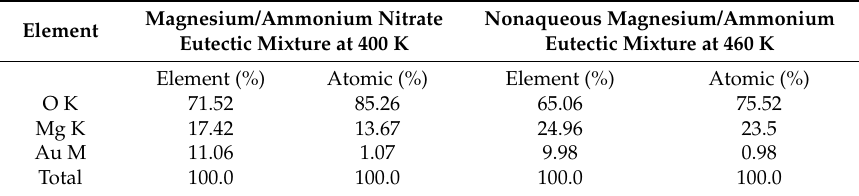
Figure 4. EDX maps of magnesium, oxigen and nitrogen distribution after 2 h of magnesium underpotential deposition onto gold substrate from: ( a ) magnesium/ammonium nitrate eutectic mixture melt at 400 K and ( b ) nonaqueous magnesium/ammonium nitrate eutectic mixture melt at 460 K. Table 1. Results of EDS semi-quantitative analysis for the Au substrates exposed to constant potential of +0.100 V for 2 h at 400 K and 460 K in used melts.